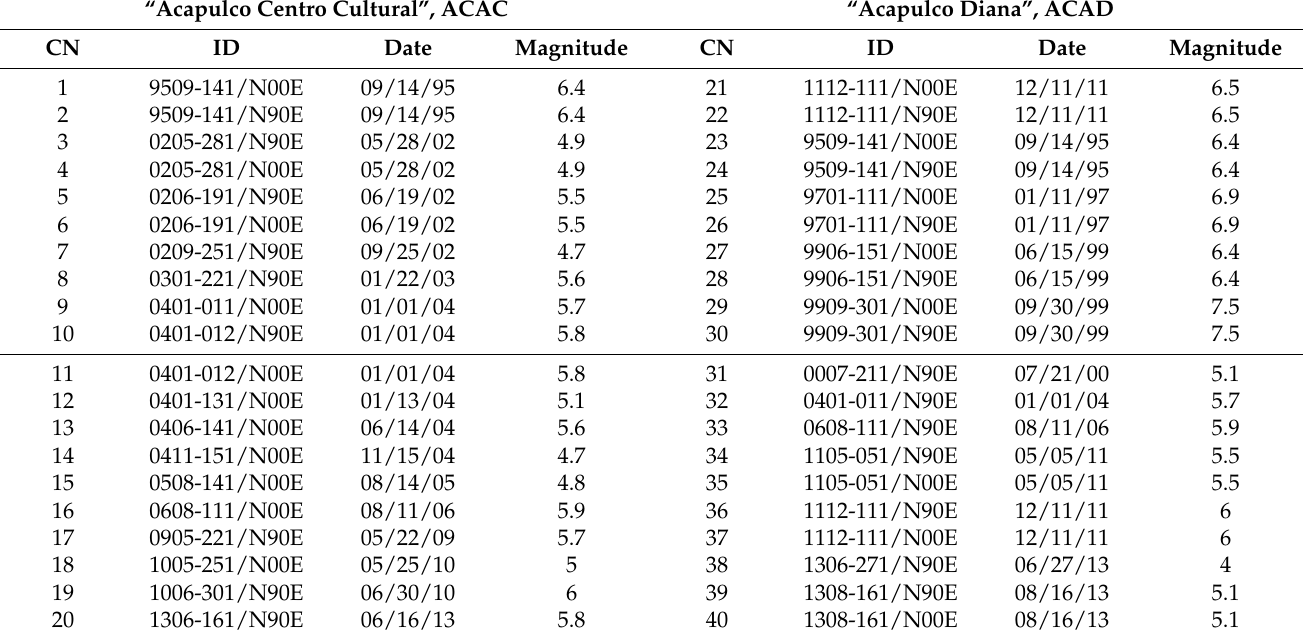
Figure 6. Median of the maximum drift. Table 5. Characteristics of 40 seismic records.